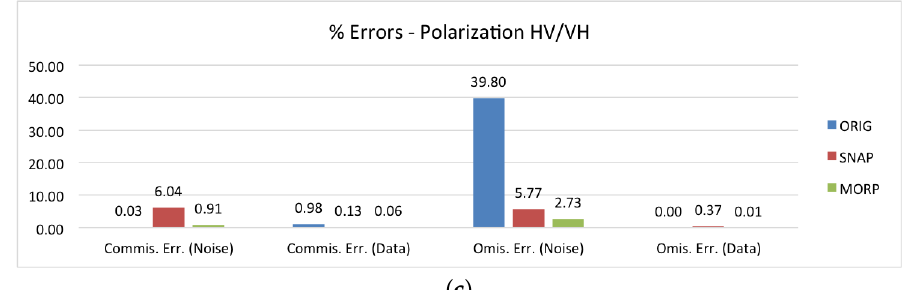
Figure 8. Performance assessment of the proposed method ( MORP ), compared to the original unmasked images ( ORIG ) and the images masked via SNAP’s ‘Remove GRD Border Noise’ module ( SNAP ): ( a , c ) commission/omission errors disaggregated by the polarization channel.